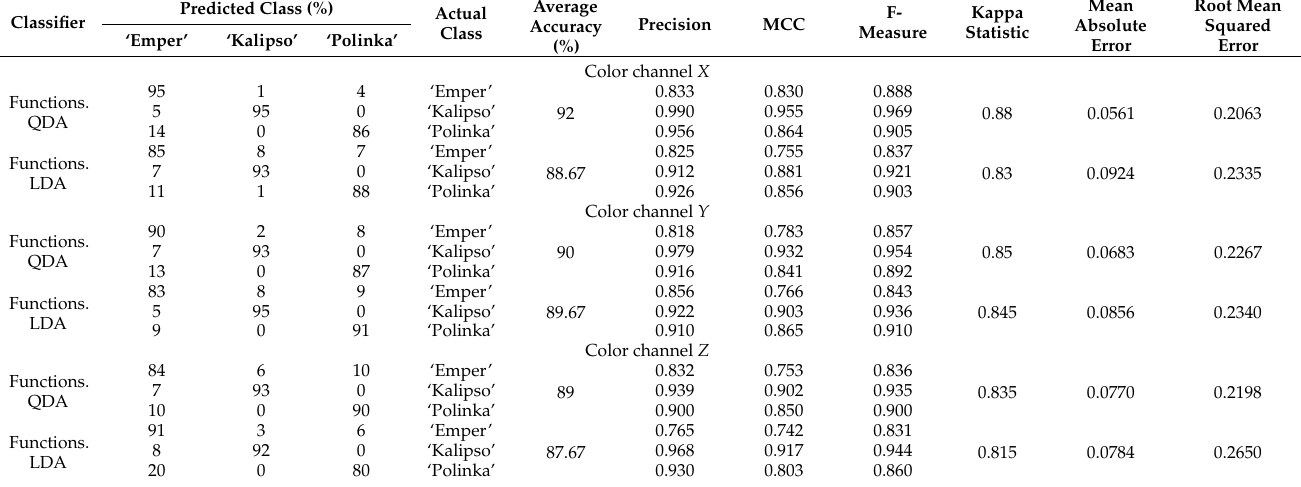
Table 4. The cultivar discrimination of plum stones based on textures selected from individual color channels X , Y , and Z